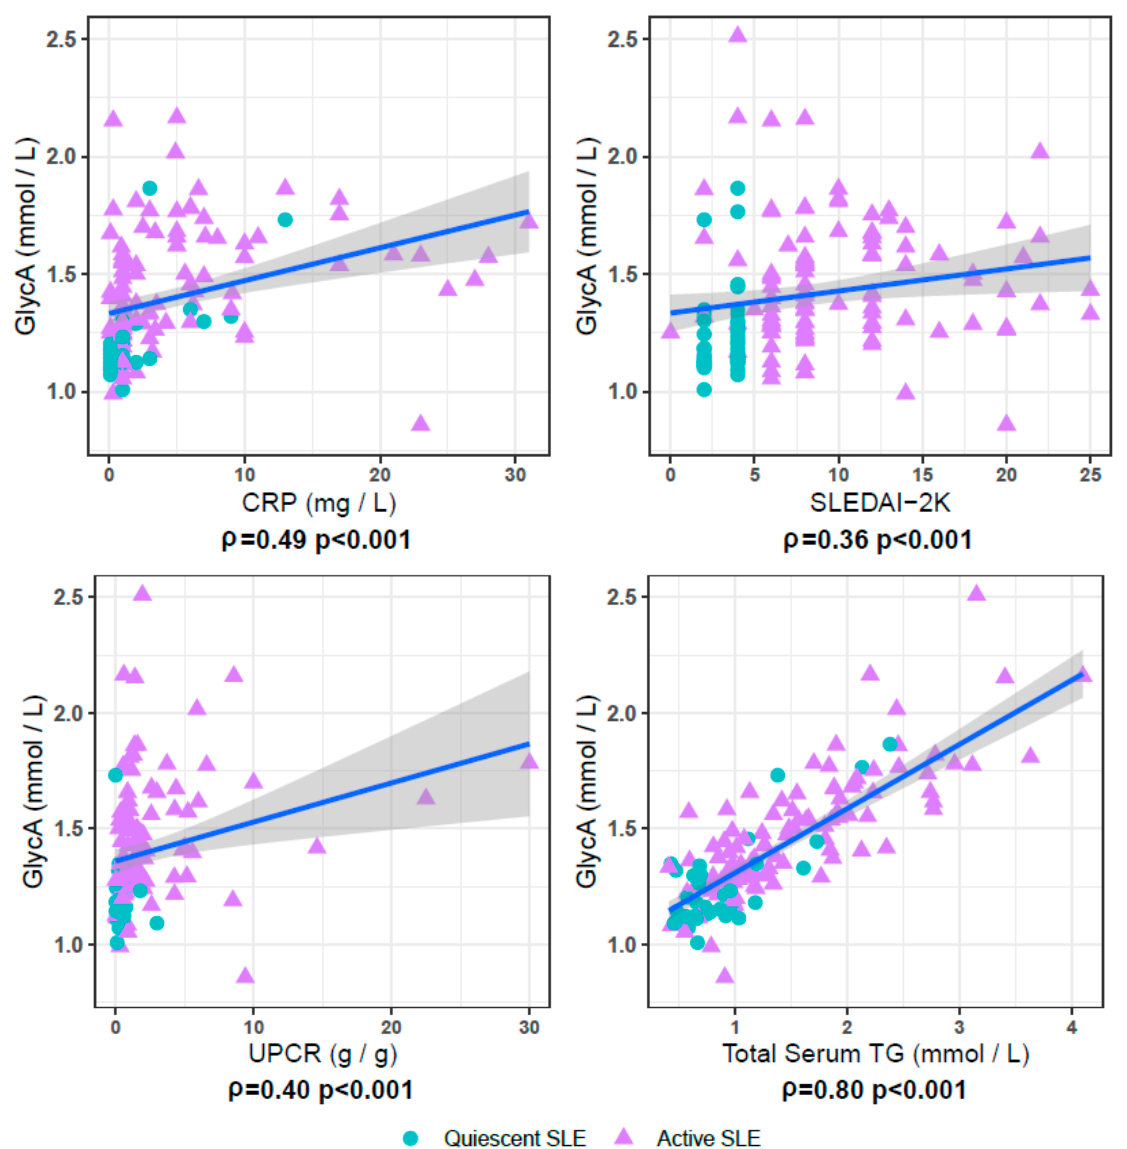
SLE patient samples, comprising samples from clinically quiescent patients (blue circles, n = 39) and from patients with active disease (purple triangles, n = 105), GlycA significantly correlates with C-reactive protein (CRP), SLE disease activity index 2K (SLEDAI-2K), and urinary protein / creatinine ratio (UPCR). Also depicted is the strong correlation between serum triglyceride (TG) and GlycA